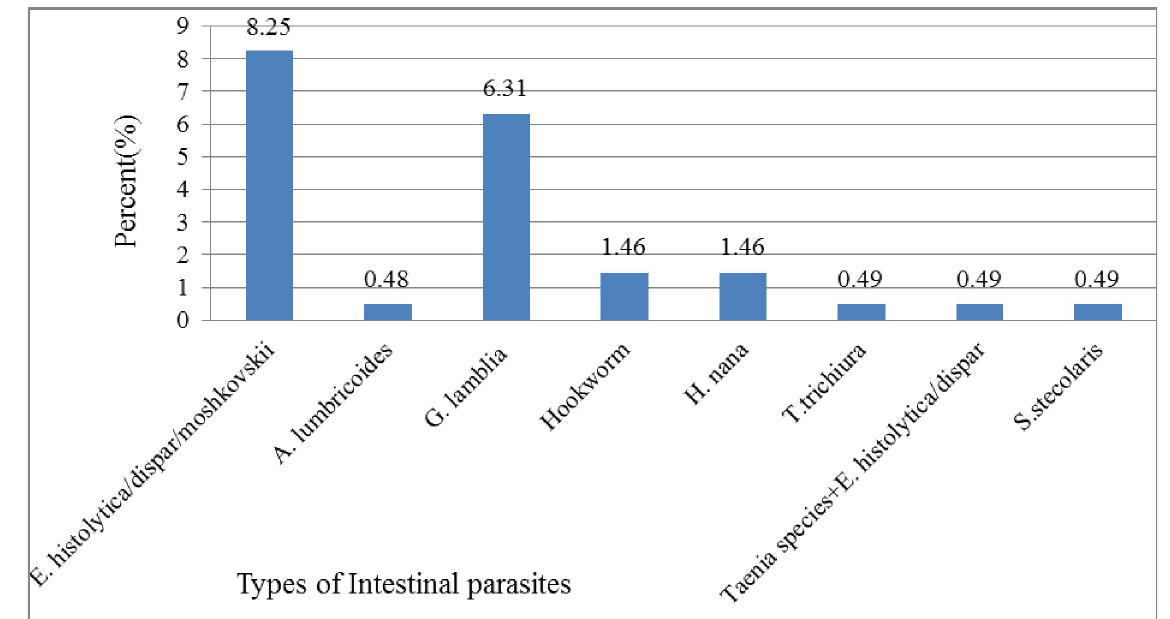
Fig 5. Intestinal parasitic infections among smear negative individuals in Kuyu General Hospital, 2020 (n = 206).